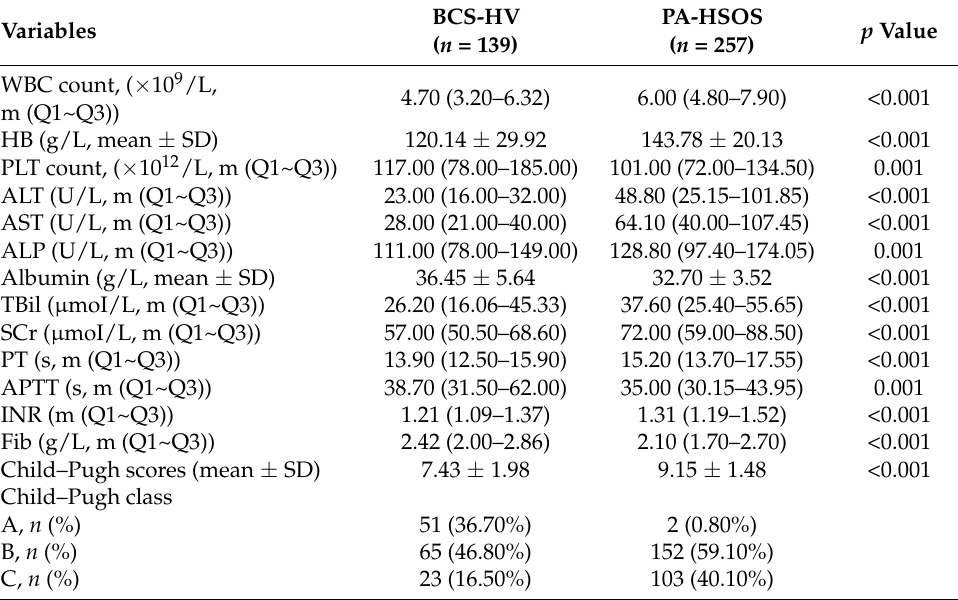
Table 2. Baseline characteristics of the laboratory